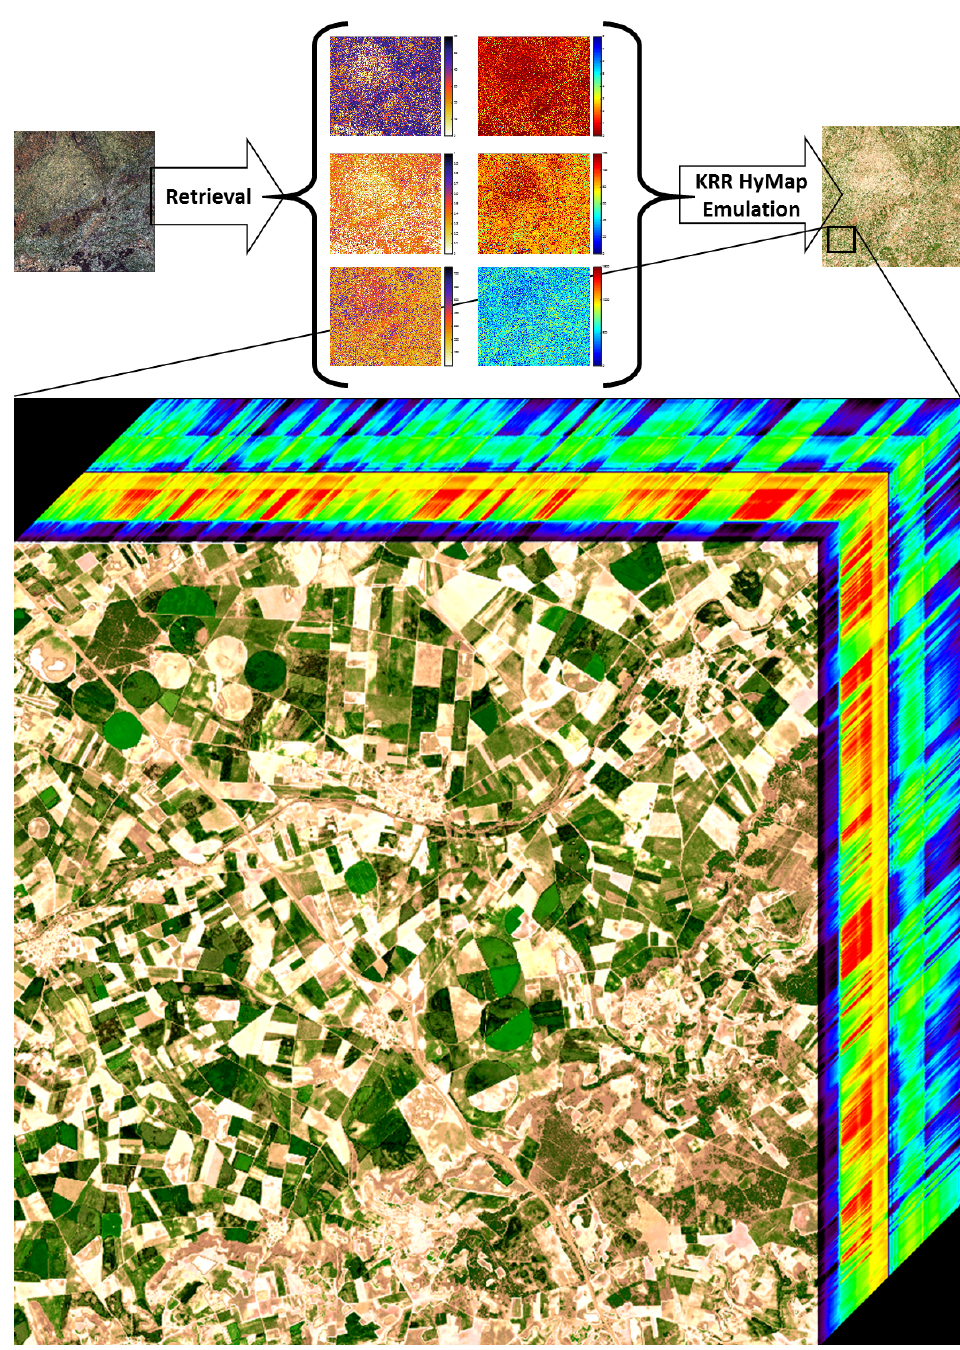
Figure 10. Schematic overview of RGB- and KRR-emulated synthetic hyperspectral S2-like image and data cube visualization of emulated subset over agricultural site Valladolid, Spain (R: 646.5 nm; G: 554.9 nm; B: 462.4